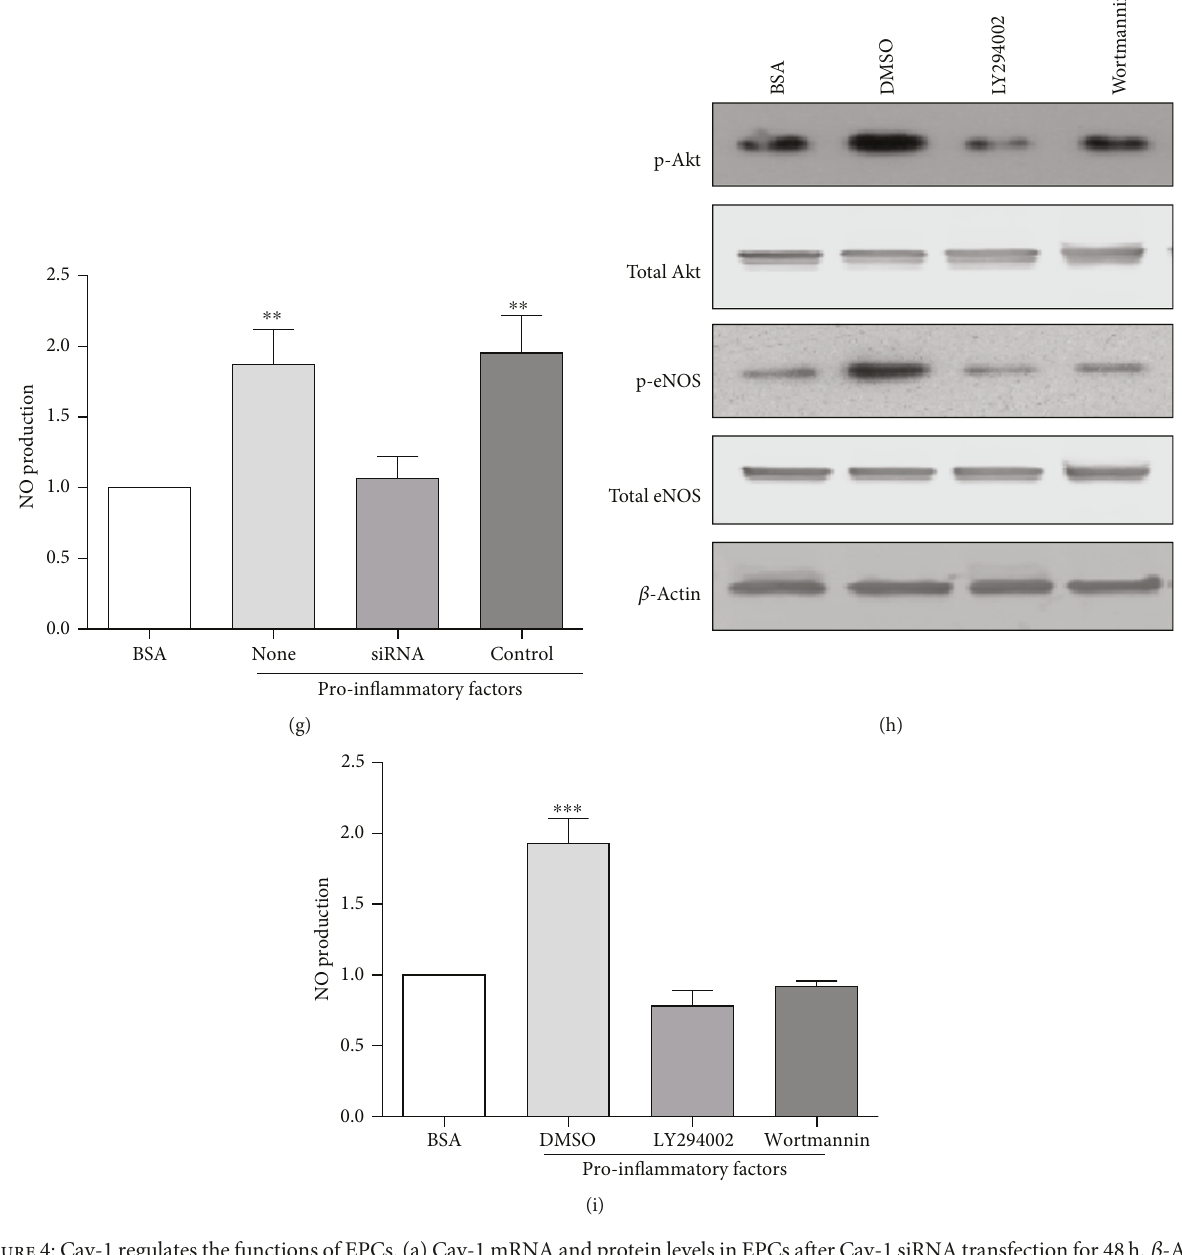
Figure 4: Cav-1 regulates the functions of EPCs. (a) Cav-1 mRNA and protein levels in EPCs after Cav-1 siRNA transfection for 48h. β -Actin was used as internal control. (b) Cell proliferation of EPCs after Cav-1 siRNA transfection determined by MTT assay. (c) Cell migration of EPCs after Cav-1 siRNA transfection assessed by wound healing assay. (d) The angiogenic ability of EPCs after Cav-1 siRNA transfection evaluated by tube formation assay. (e) Cav-1 mRNA and protein levels in EPCs after incubation with proin fl ammatory factors and indicated inhibitors. β -Actin was used as internal control. (f) The protein expression levels of p-AKT, total AKT, p-eNOS, and total eNOS assessed by Western blot after incubation with proin fl ammatory factors and indicated siRNA. (g) NO levels after incubation with proin fl ammatory factors and indicated siRNA were detected by the Griess method. (h) The protein expression levels of p-AKT, total AKT, p-eNOS, and total eNOS assessed by Western blot after incubation with proin fl ammatory factors and indicated inhibitors. (i) NO levels after incubation with proin fl ammatory factors and indicated inhibitors were detected by the Griess method. ∗ P < 0 05 vs. the control